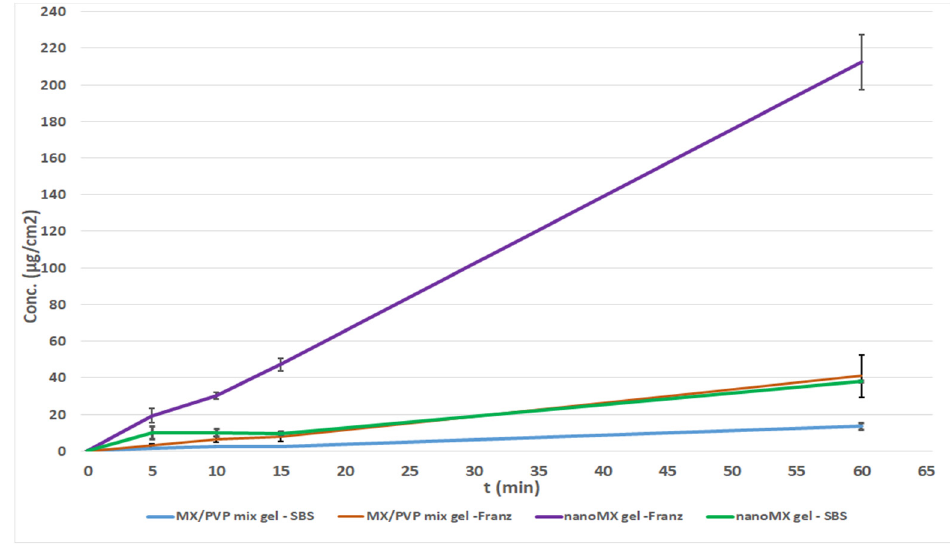
Figure 5. In vitro permeability of intranasal gels on Franz and Side-Bi-Side diffusion systems.